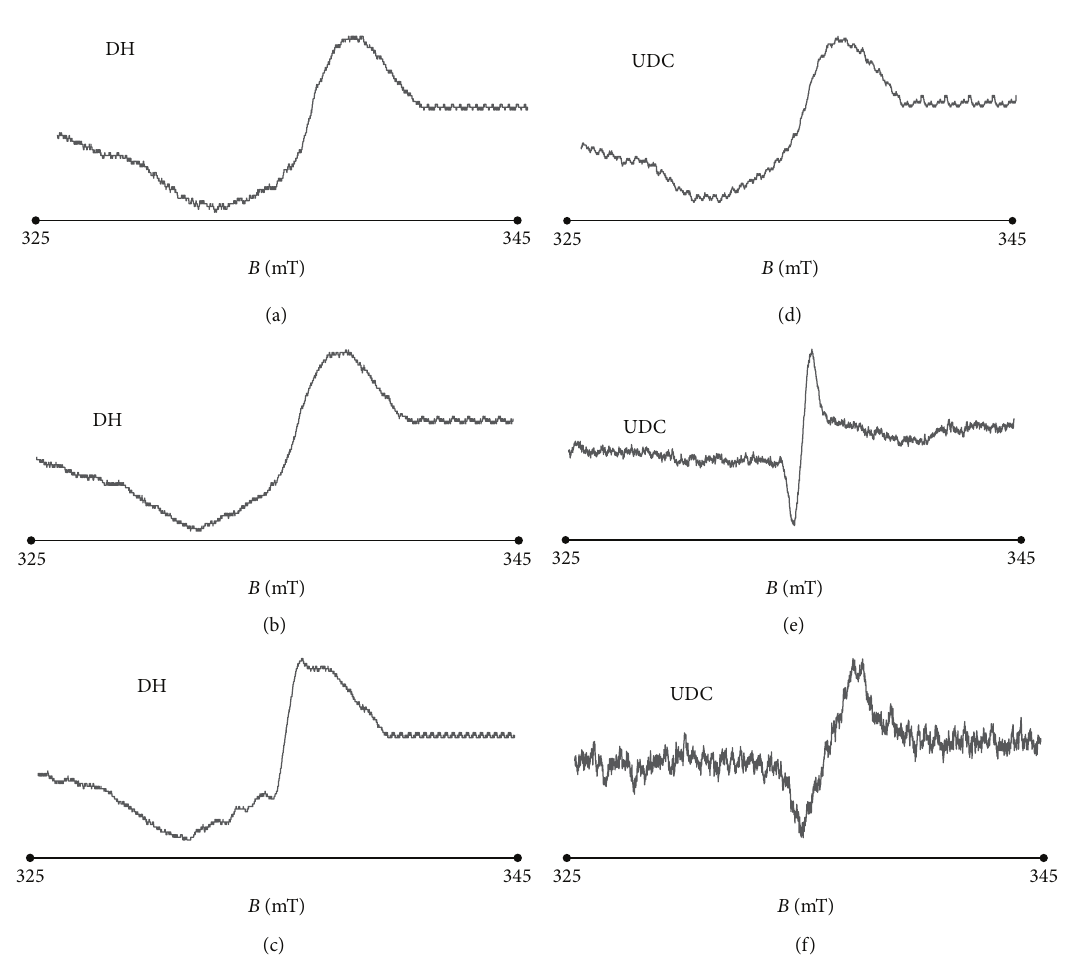
Figure 6: EPR spectra of DH and UDC thermally sterilized at 160 ∘ C: (a) and (d); at 170 ∘ C (b) and (e); at 180 ∘ C (c) and